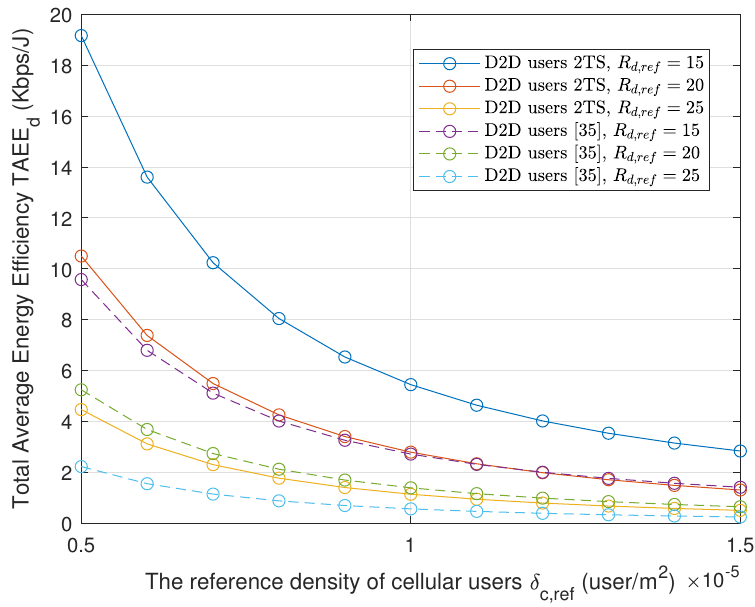
Figure 4. The TAEE of D2D communication in 2TS versus δ c , ref .